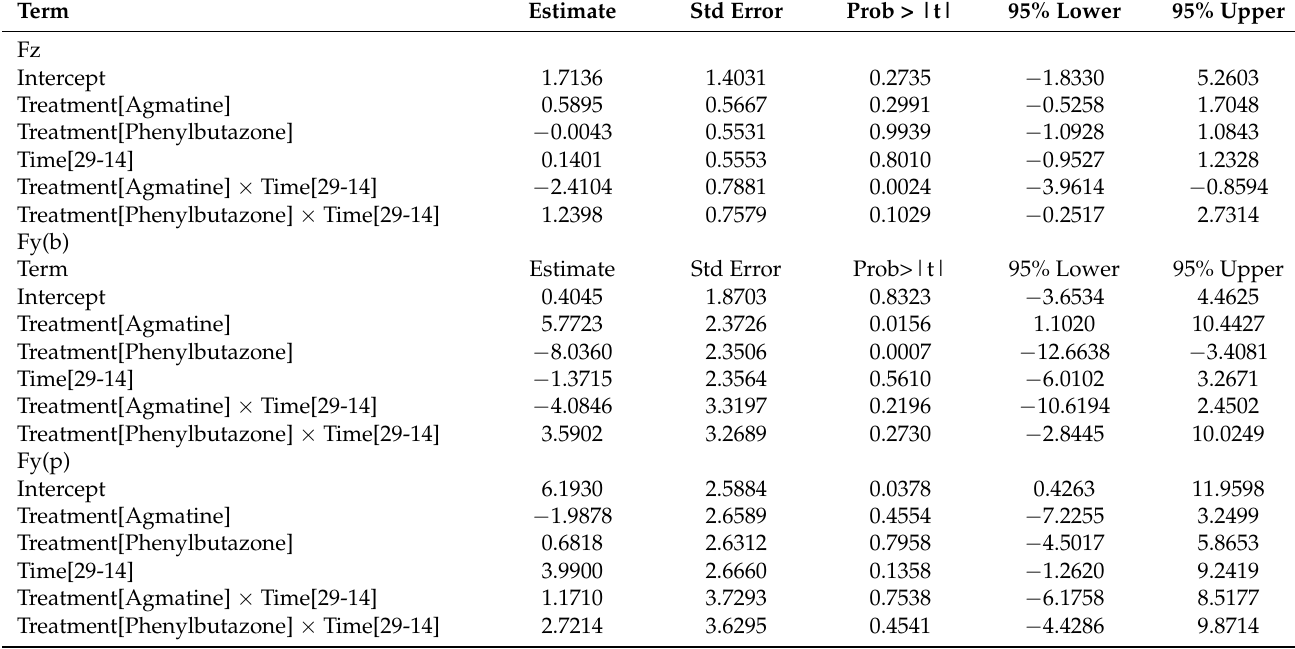
Table 7. Fixed effect parameter estimates of on-impulse percentage changes. Std Error: standard